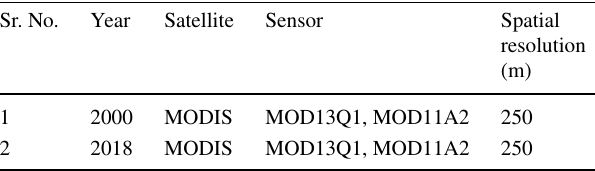
Table 1 Characteristics of remotely sensed data used for desertifica- tion analysis Sr.